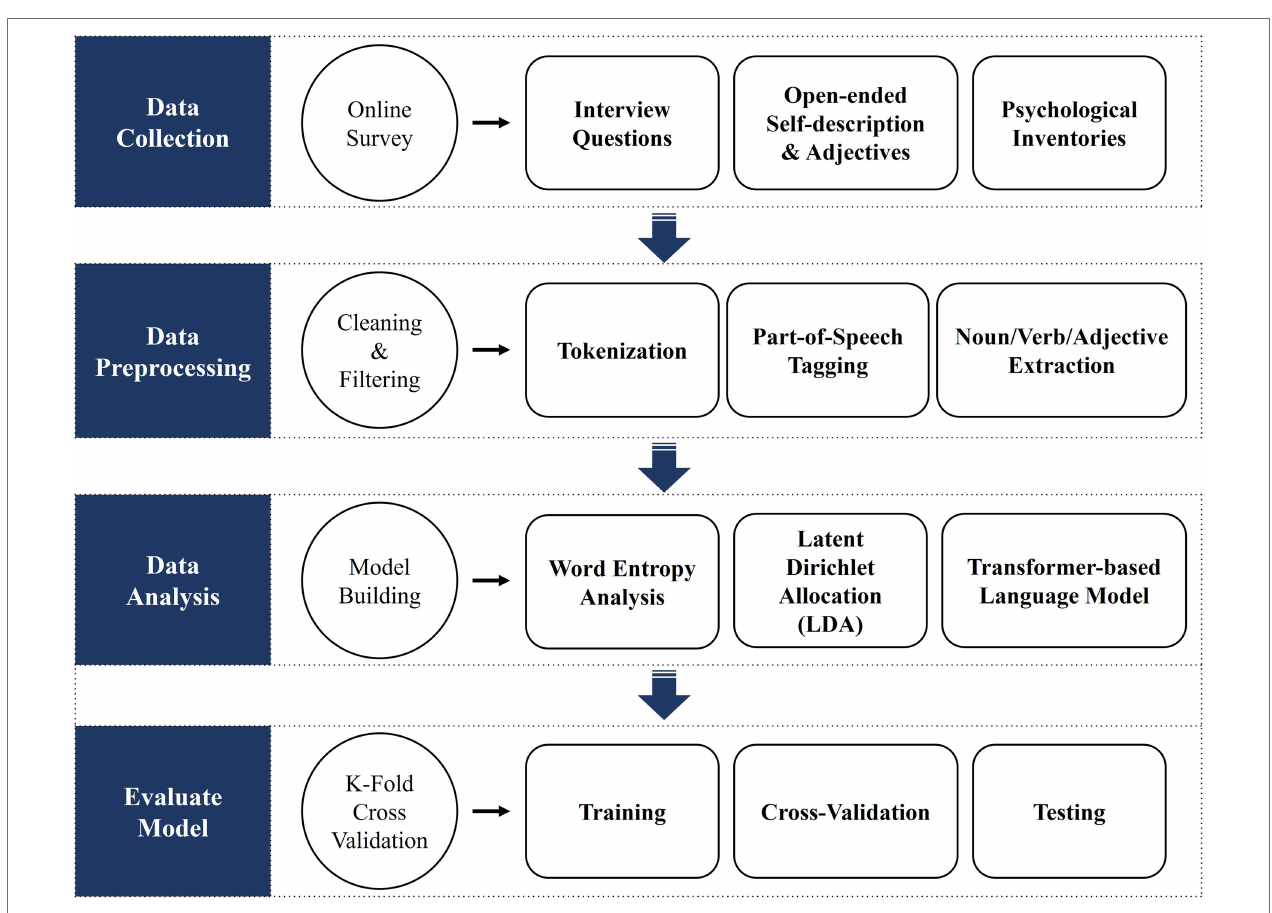
FIGURE 2 | Data analysis